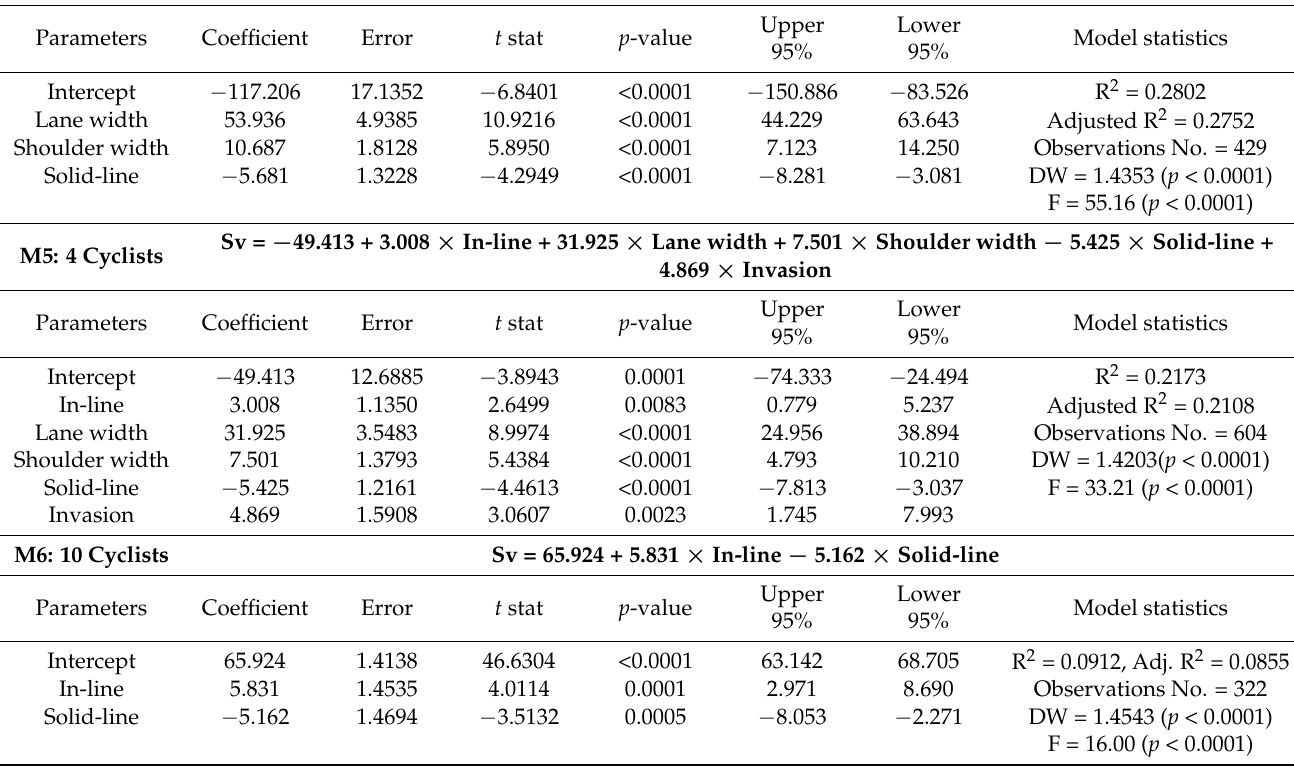
Table 5. Regression models for overtaking vehicle speed considering the different cyclist